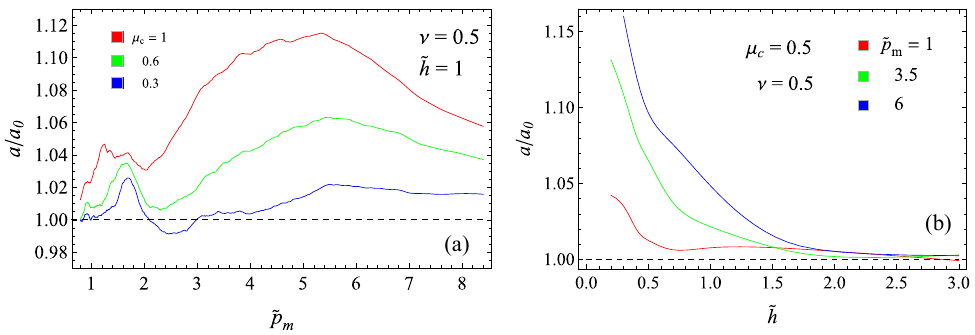
Figure 5. The contact area ratio ( a 0 is the contact area for uncoupled case, i.e., with µ c = 0) as a fuction of ( a ) the dimensionless contact mean pressure ˜ p m = 2 layer thickness ˜ h = q 0 h .